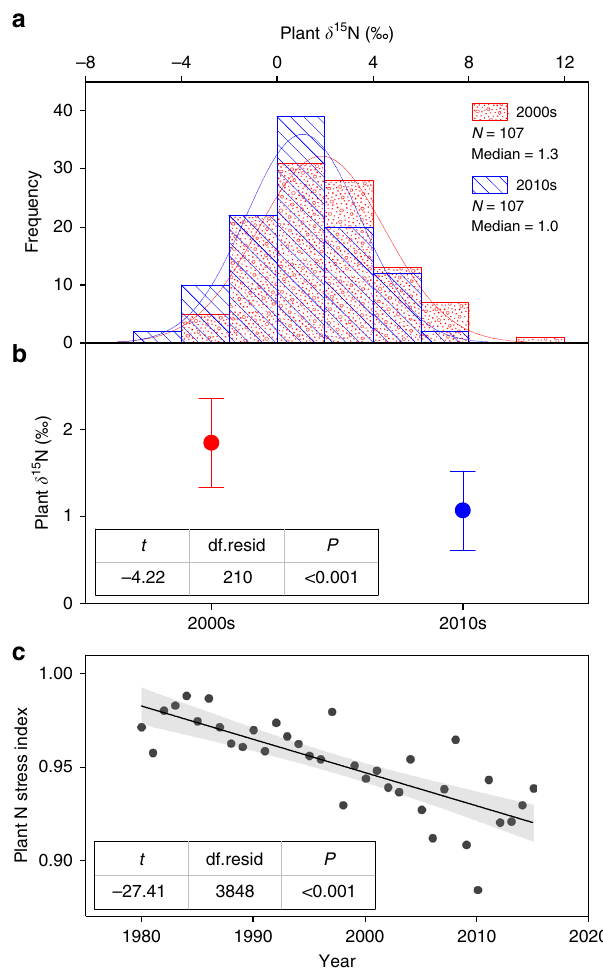
Fig. 2 Changes in plant δ 15 N and N stress index over time. a – c Frequency distributions of plant δ 15 N during the two sampling periods, changes in plant δ 15 N derived from the large-scale resampling investigations and changes in plant N stress index derived from the DeNitri fi cation- DeComposition (DNDC) model, respectively. Plant N stress index refers to the supply of N relative to plant demand, with a lower value meaning a greater limitation of N on plant growth 38 – 40 . Temporal dynamics of both indicators were examined with linear mixed-effects models, in which the fi xed effect was year and the random effect was sampling site. Points in b denote mean values and error bars represent 95% con fi dence intervals. The shade accompanying with the solid fi tted line in c represents 95% con fi dential interval. N , the number of sites used for analyzing plant δ 15 N; median, median value of plant δ 15 N; df.resid, residual degrees of